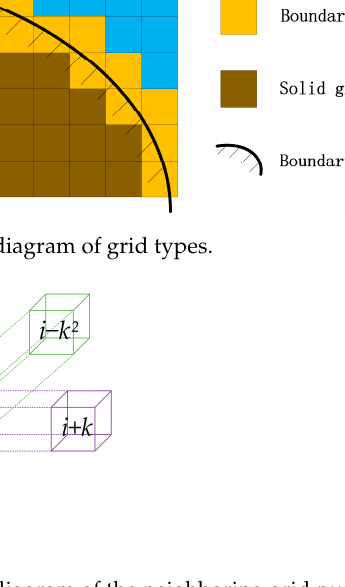
Figure 5. Schematic diagram of the neighboring grid numbers of the six faces of the grid in 3D case.